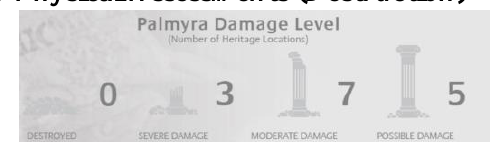
Figure (17) physical assessment by World heritage center 2014 was fooled with other assessment ( ).